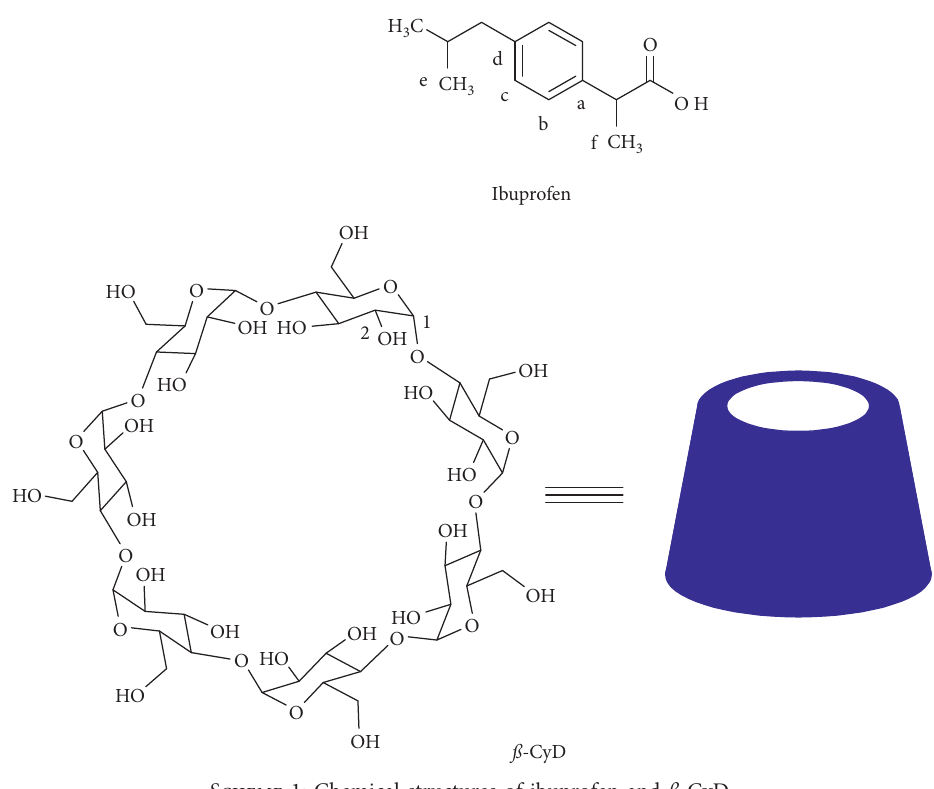
Scheme 1: Chemical structures of ibuprofen and β -CyD.